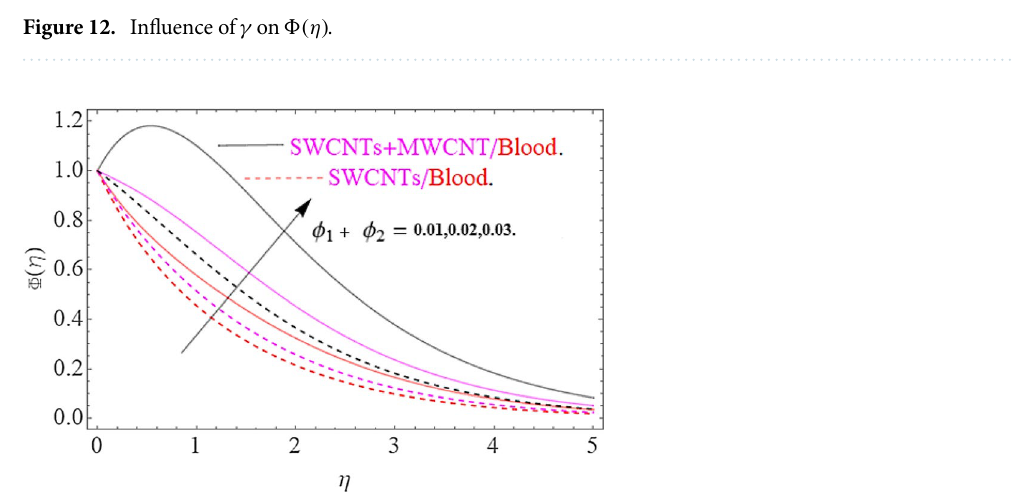
Figure 13. Impact of φ 1